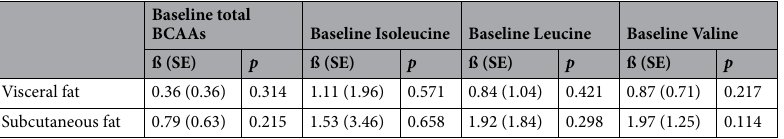
Table 3. Associations of adiposity measures and total BCAAs, Isoleucine, Leucine, or Valine before exercise intervention among individuals with nonalcoholic fatty liver disease. ß (SE) per unit of change in total BCAAs, Isoleucine, Leucine, or Valine for differences in the adiposity measures after adjustment for age, sex, total energy intake, protein intake, intervention group, HOMA-IR, and BMI. Abbreviations: HOMA-IR homeostatic model assessment of insulin resistance; BMI body mass index.